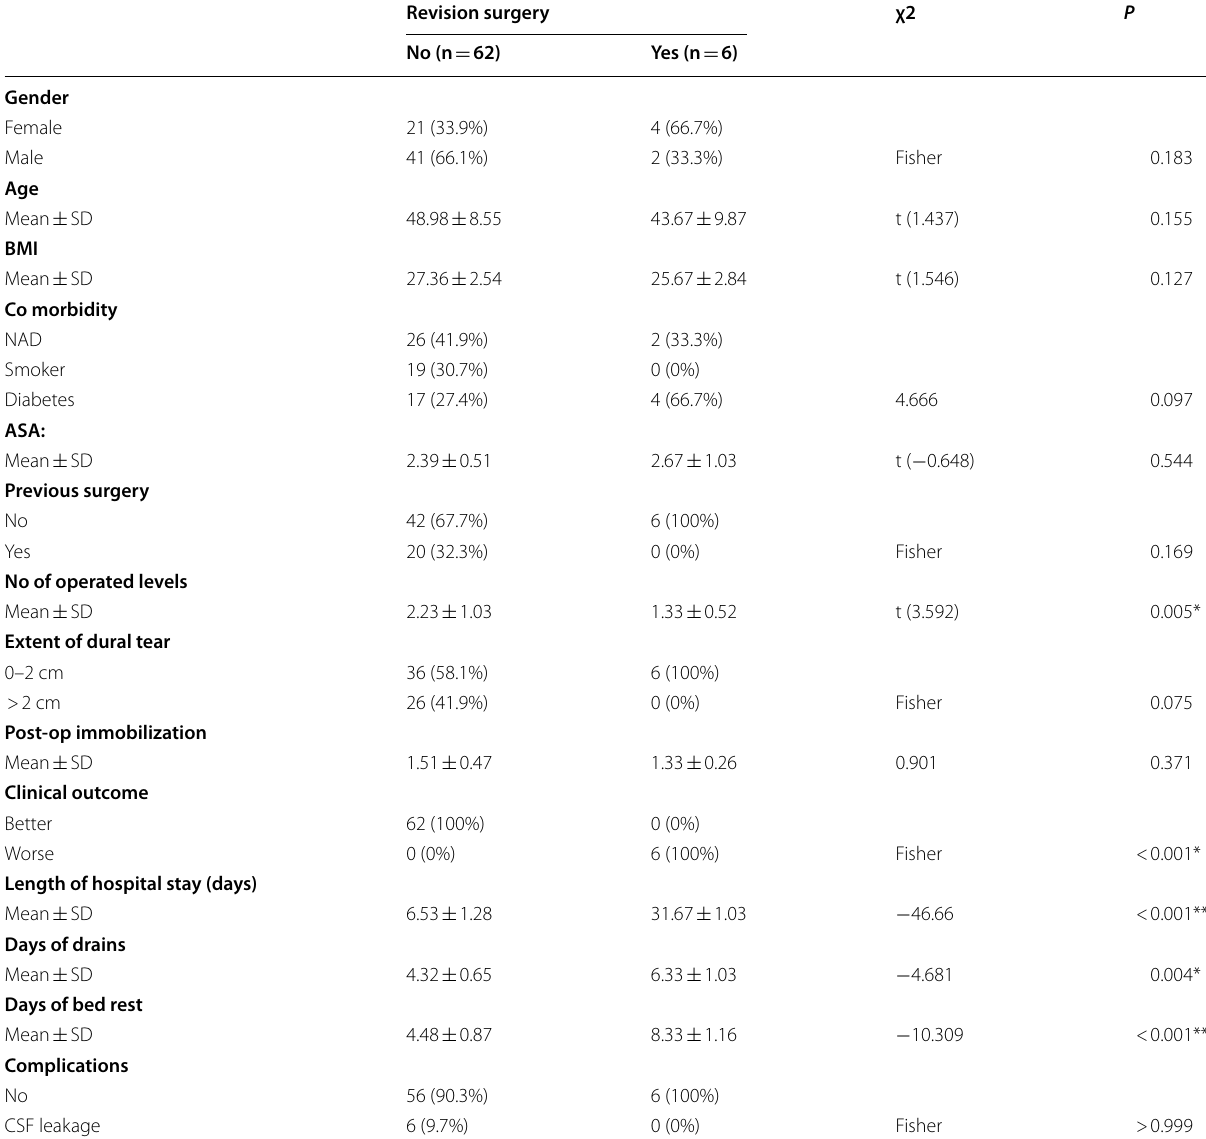
Table 4 Relation between pre, postoperative variables and the need for revision surgery among studied